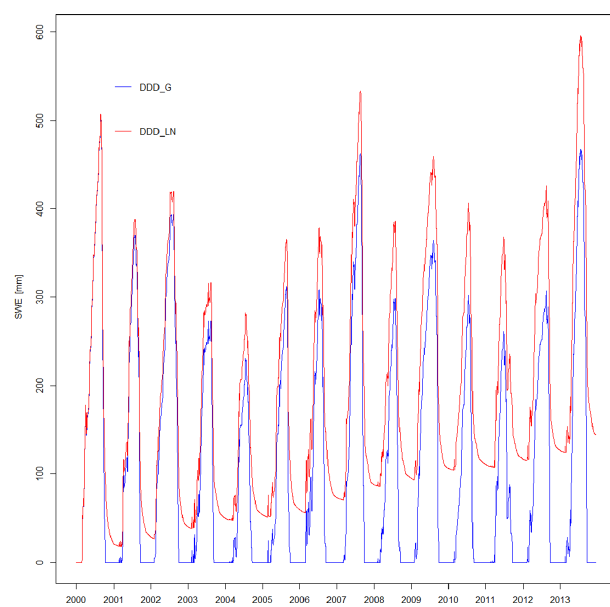
Figure 6. Time series of simulated SWE using DDD_G (blue line) and DDD_LN (red line) for catchment Tansvatn in Southern Nor-